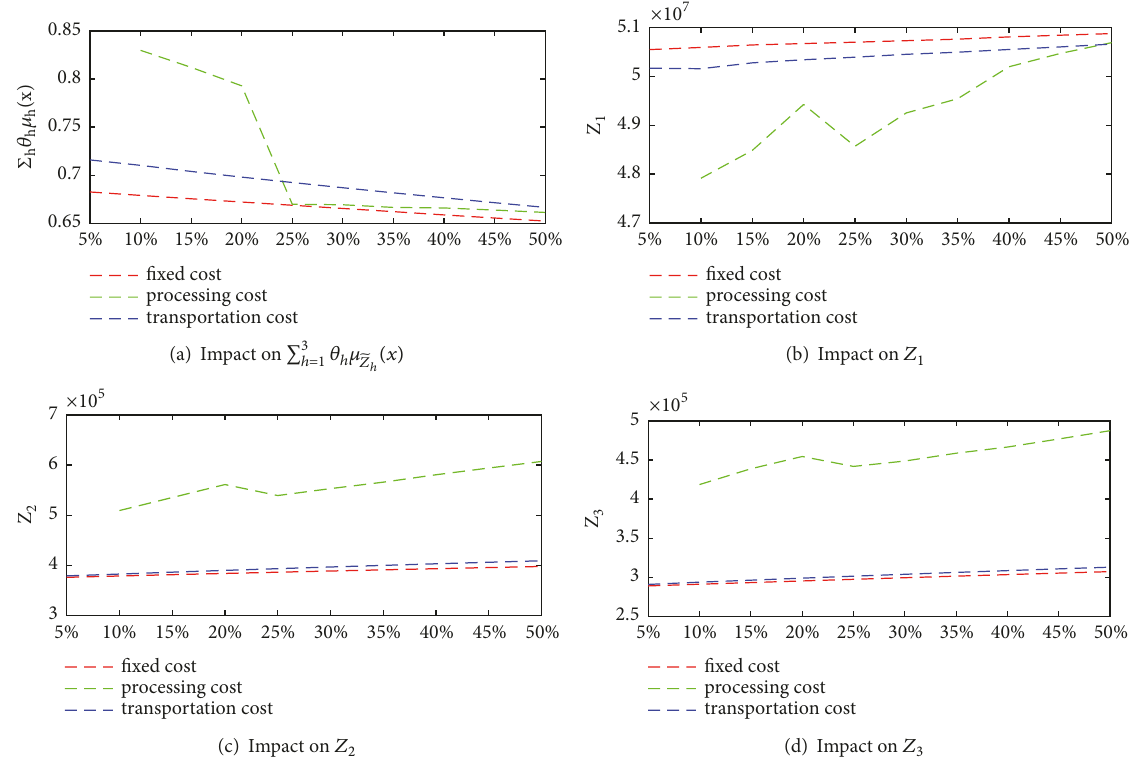
Figure 7: Sensitivity of fuzzy cost coefficients’ variance.